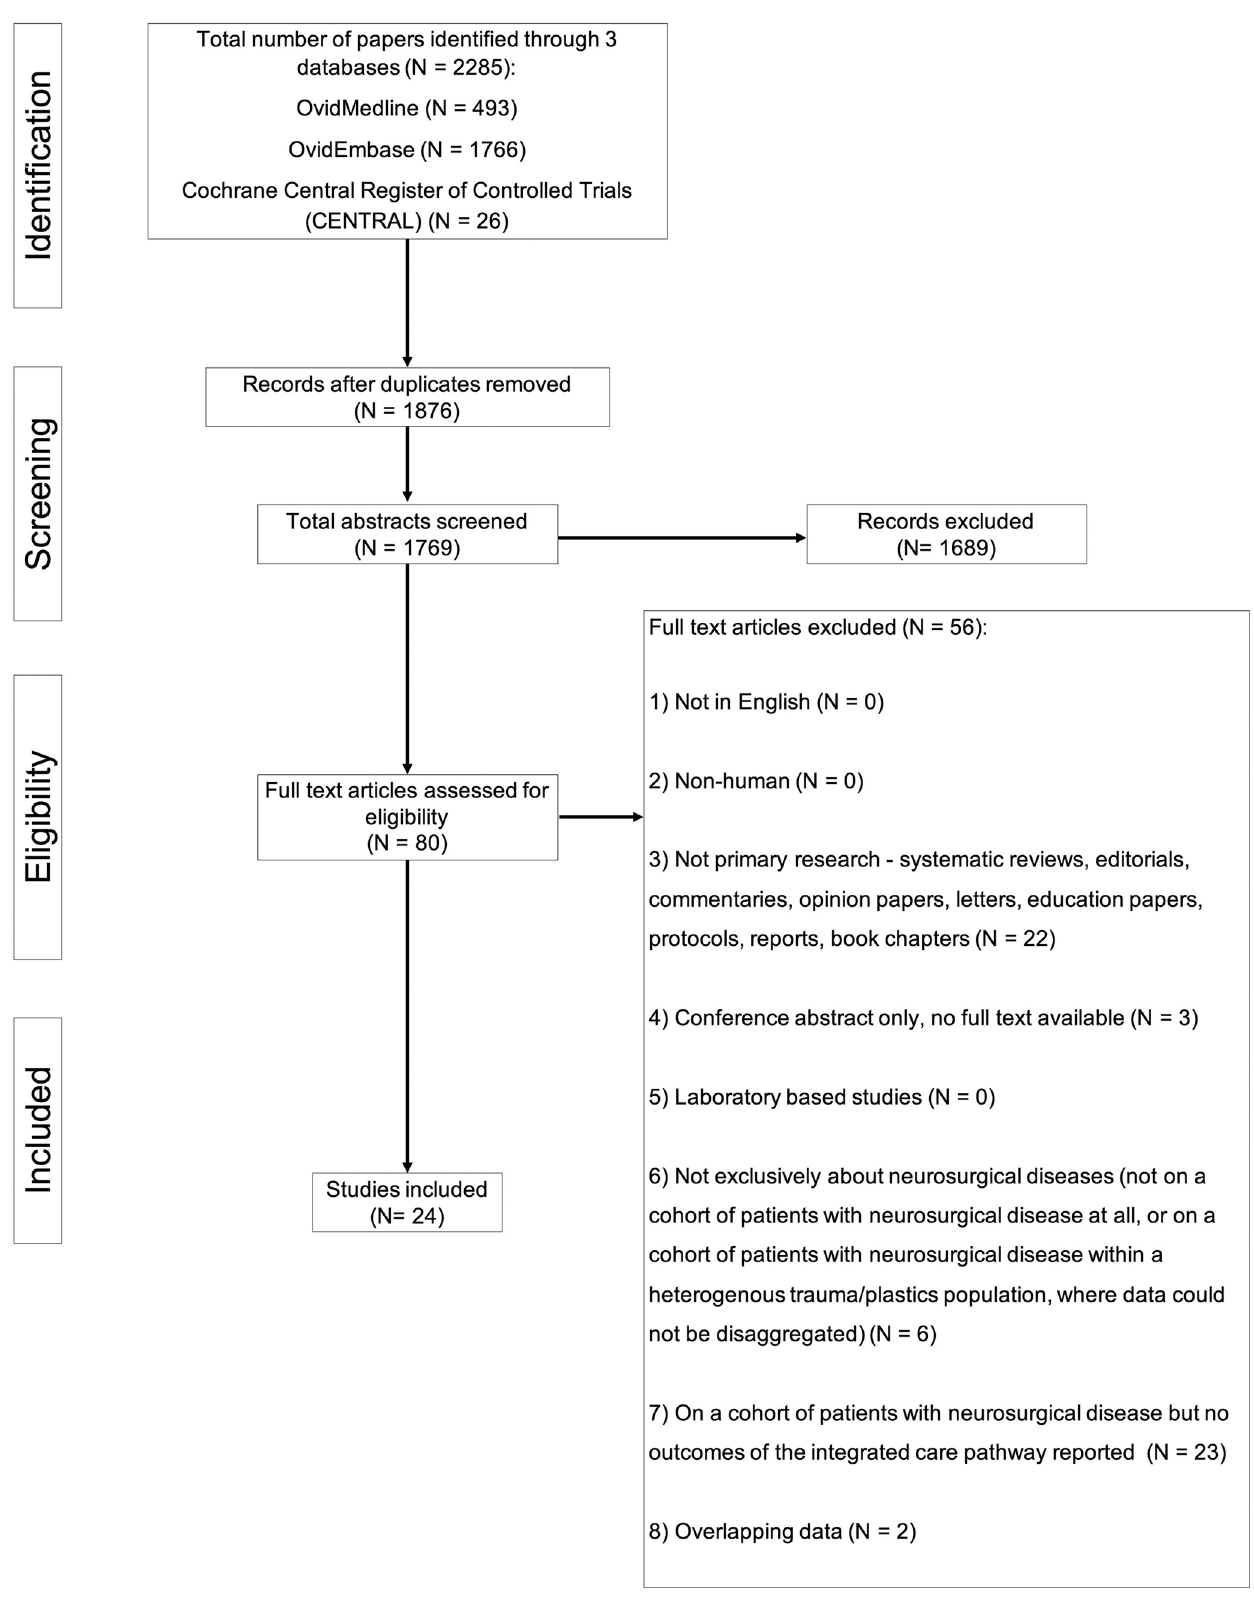
Fig 1. PRISMA flow diagram of included and excluded studies. https://doi.org/10.1371/journal.pone.0255628.g001 PLOS ONE | https://doi.org/10.1371/journal.pone.0255628 August 2,